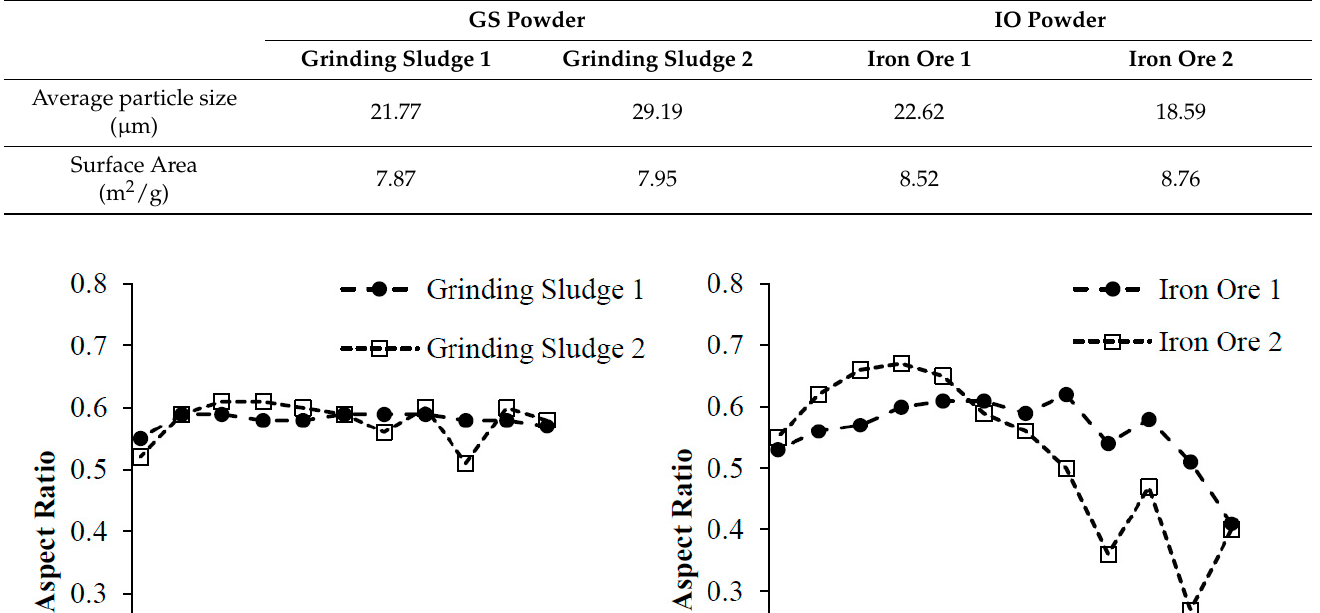
Table 2. Average particle size and surface area of iron oxide source material.